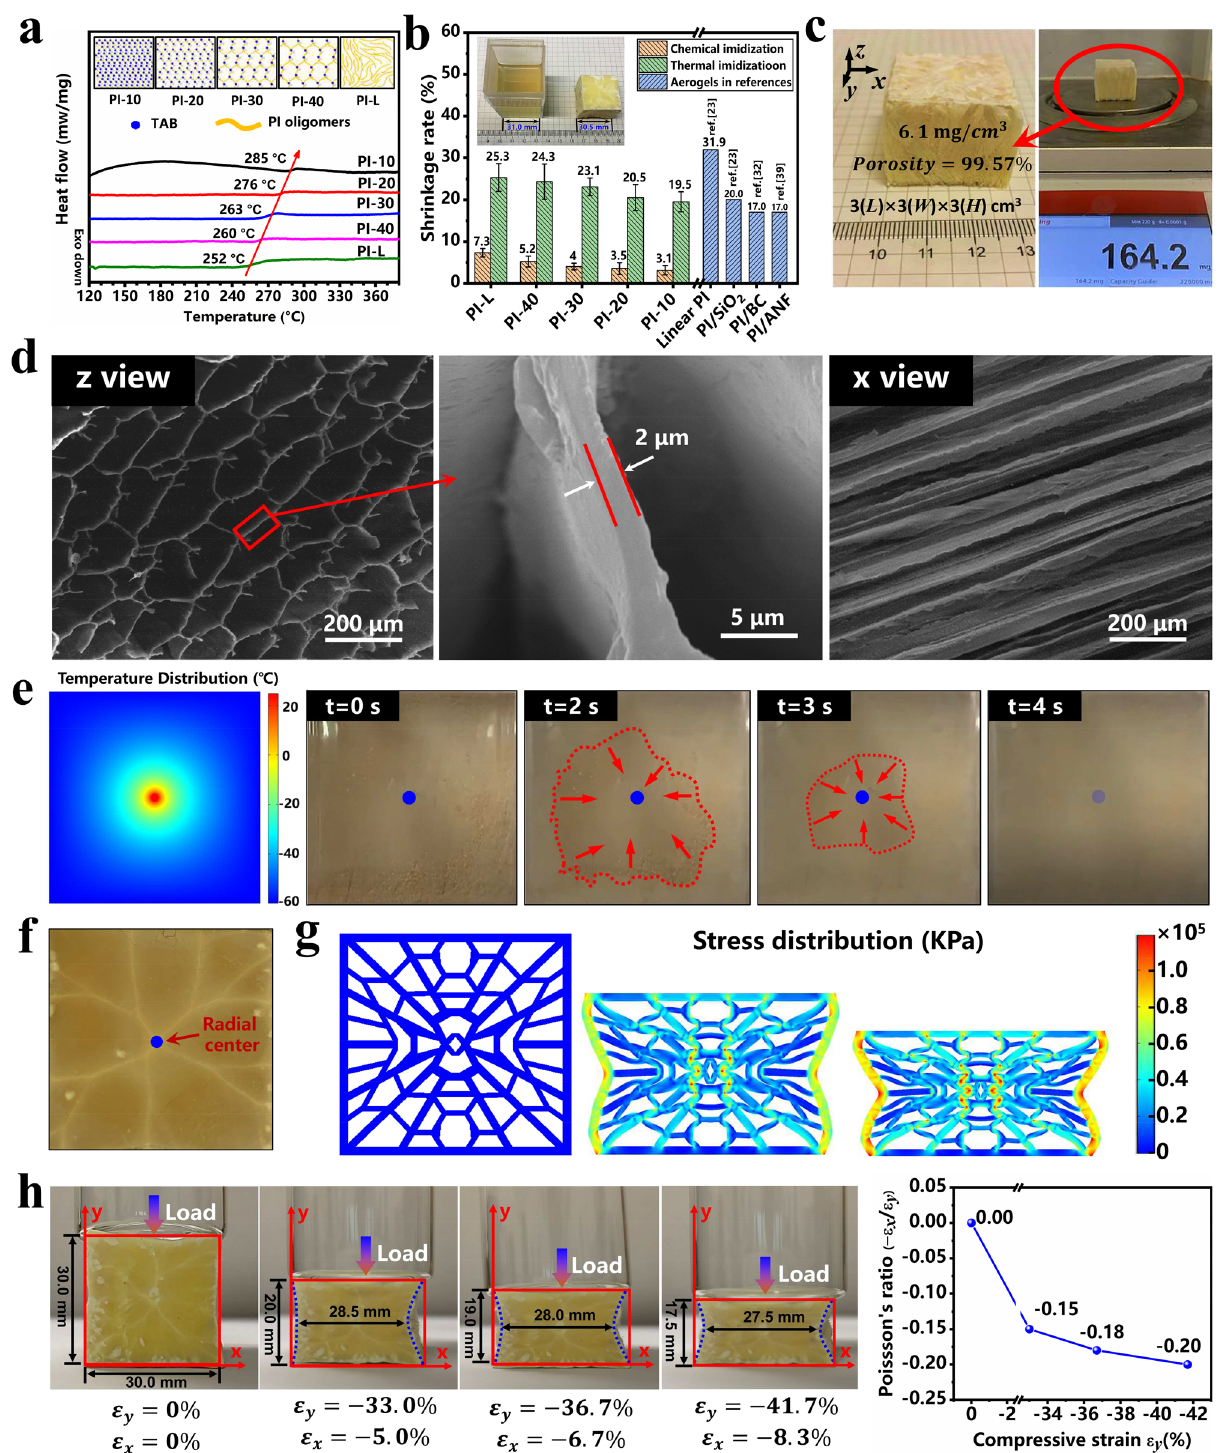
Fig. 3 Structure and morphology of PI aerogels. a DSC curves of PI aerogels. b Average shrinkage rates of PI aerogels from chemical imidization, thermal imidization, and related references, 5 parallel tests were performed on each series of samples. c Optical images of the volume and weight of a typical PI aerogel. d SEM images viewing along z-direction ( z view) and along x -direction ( x view) of anisotropic PI-10 aerogels. e Temperature distribution and growing direction of DMSO crystals at the bottom of the mold. f Overview of radial distributed morphology in PI-10 aerogels. g Simulated NPR behavior of PI aerogels. h Sequential optical images showing NPR under compression vertical channel